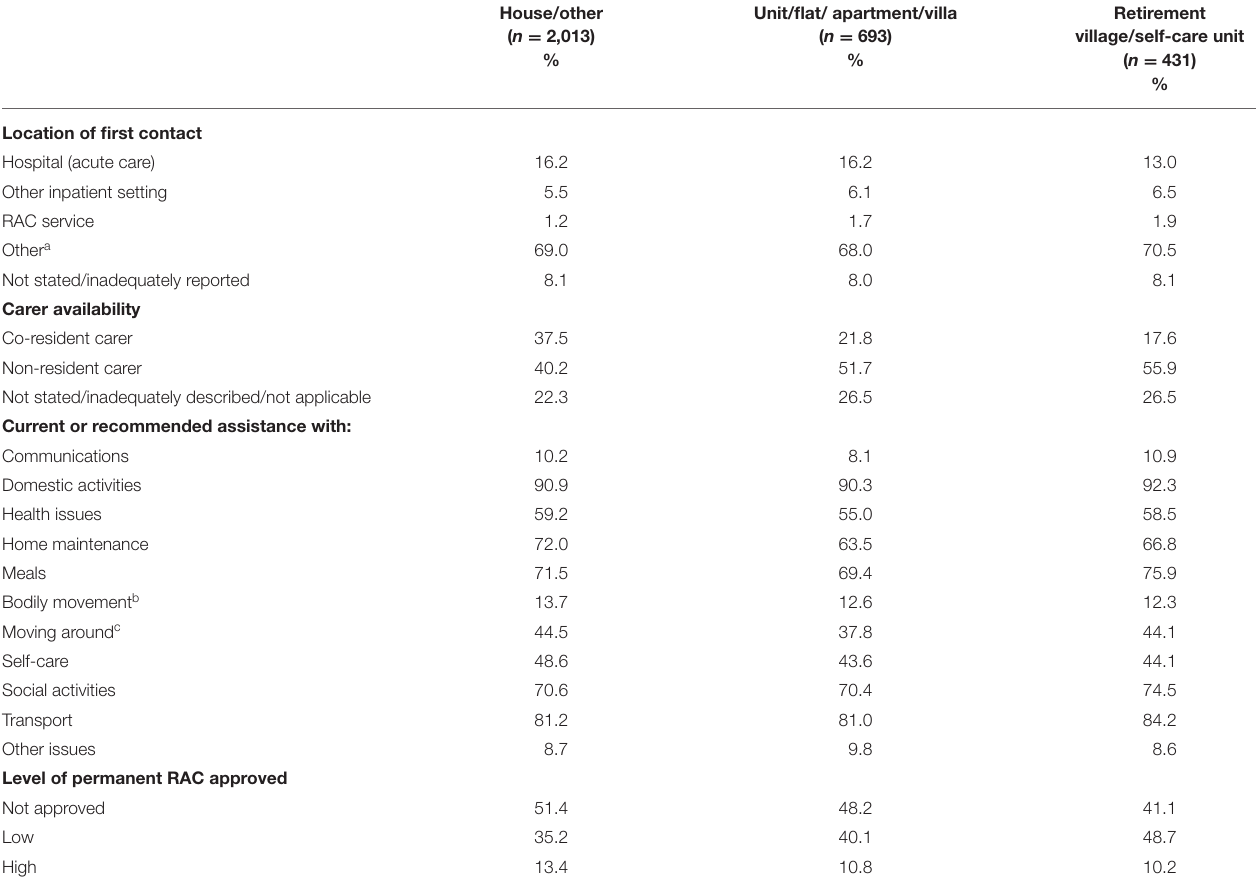
TABLE 4 | Profile characteristics of the first aged care assessment for older women, according to housing status at the survey preceding the assessment ( N = 3,137 *